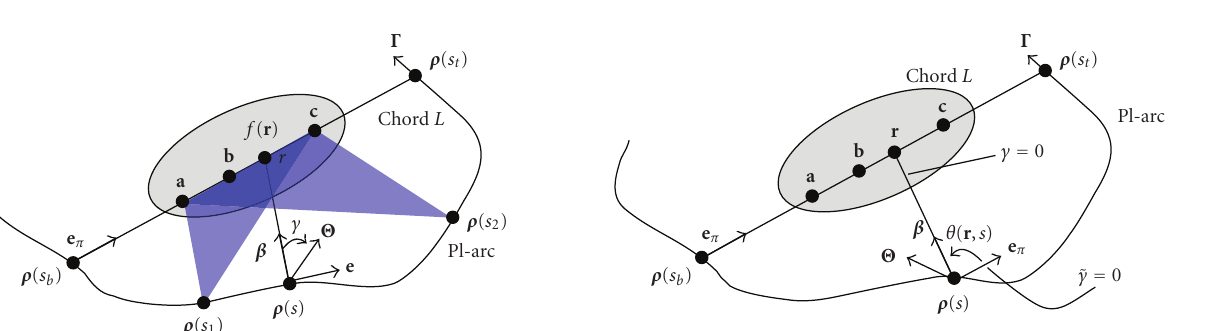
Figure 2: Variable change from γ to (cid:8) γ